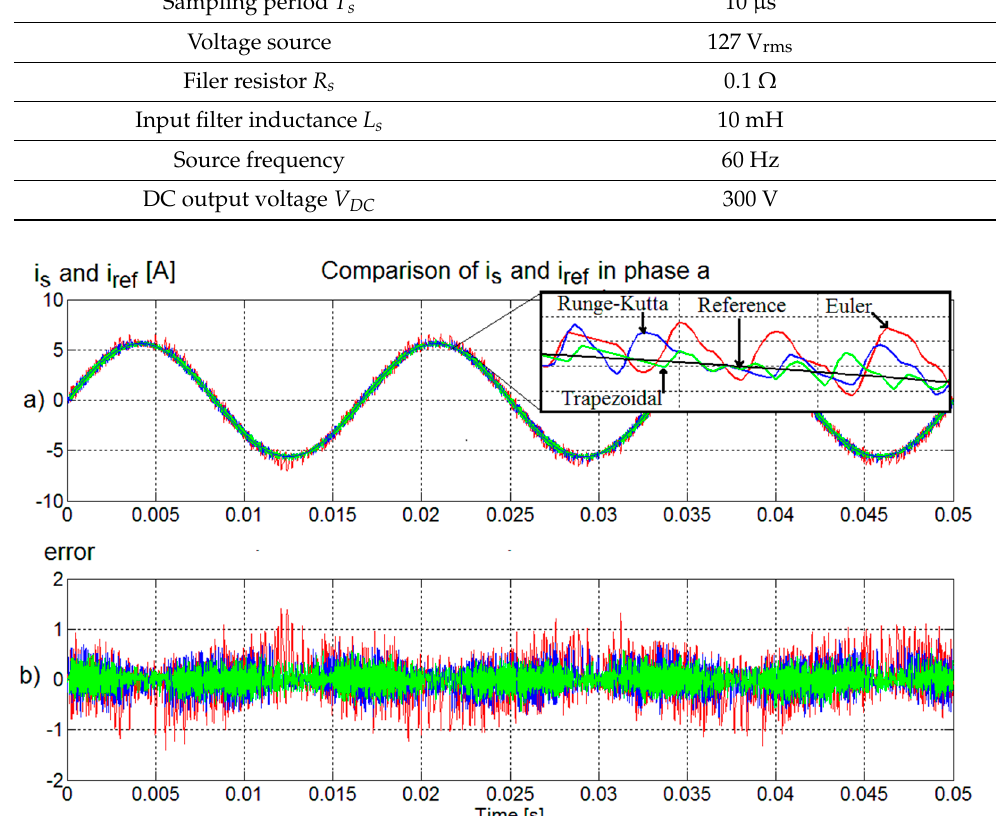
Figure 9. Comparison of i s and i ref in phase a for Euler, Runge-Kutta and firs-order trapezoidal methods ( a ) Reference source current waveform i ref and measured current waveform, i s , in phase a using Euler, Runge–Kutta, and first-order trapezoidal approximations, for Ts = 10 µ s; ( b ) error magnitude.